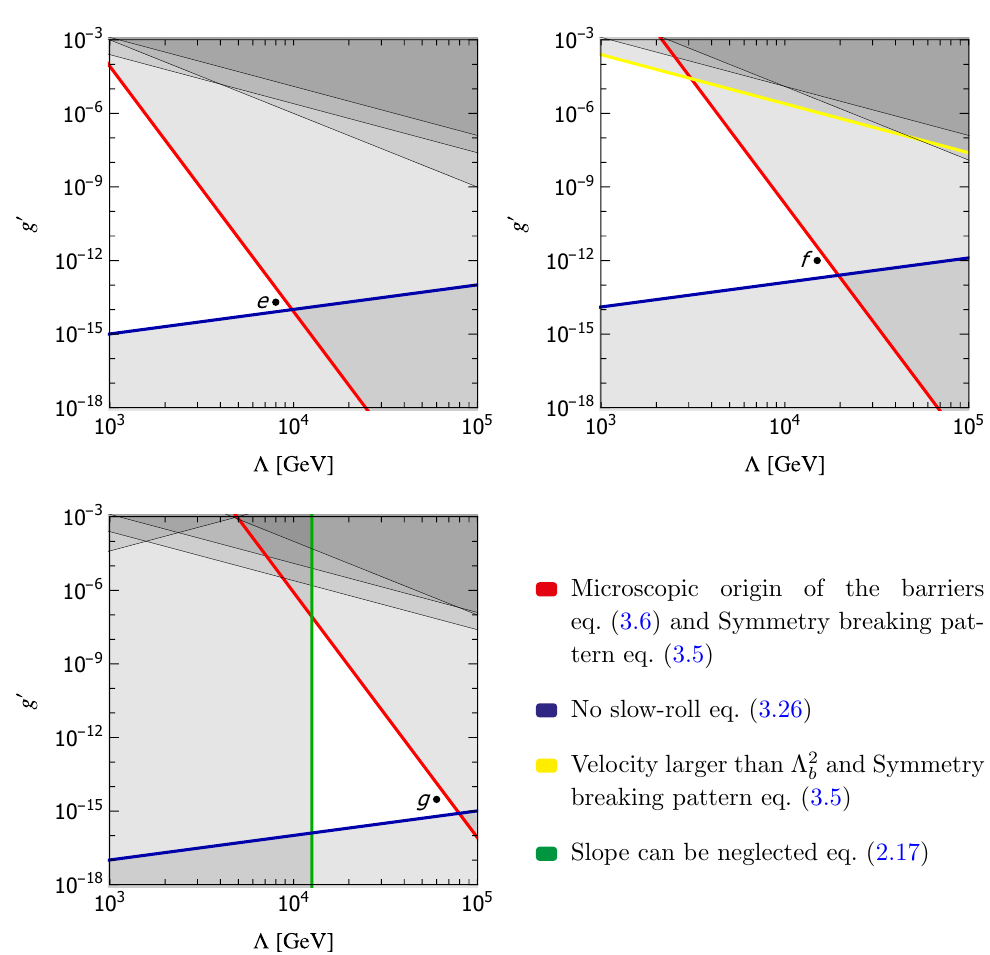
Figure 25 . Details of the origin of the constraints delimitating the regions presented in section 3.2 and (cid:12)gure 5, for benchmark points e , f and g , corresponding to the case where relaxation happens through Higgs-dependent barriers, NOT during a stage of in(cid:13)ation, where the relaxion stops because of fragmentation . Top: _ (cid:30) 0